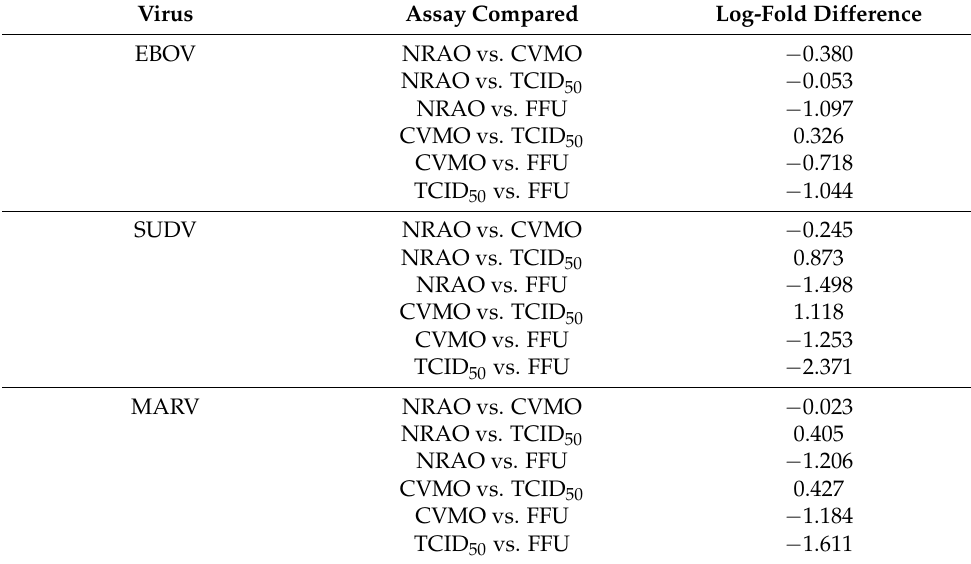
Table 2. Titer Comparison between Assays for 3 Filoviruses. Titer differences are shown in Log10- Fold difference. Turkey’s Multiple Comparison test was used to determine significance of difference between titers of each assay, per virus. Statistical significance was set at p < 0.05.